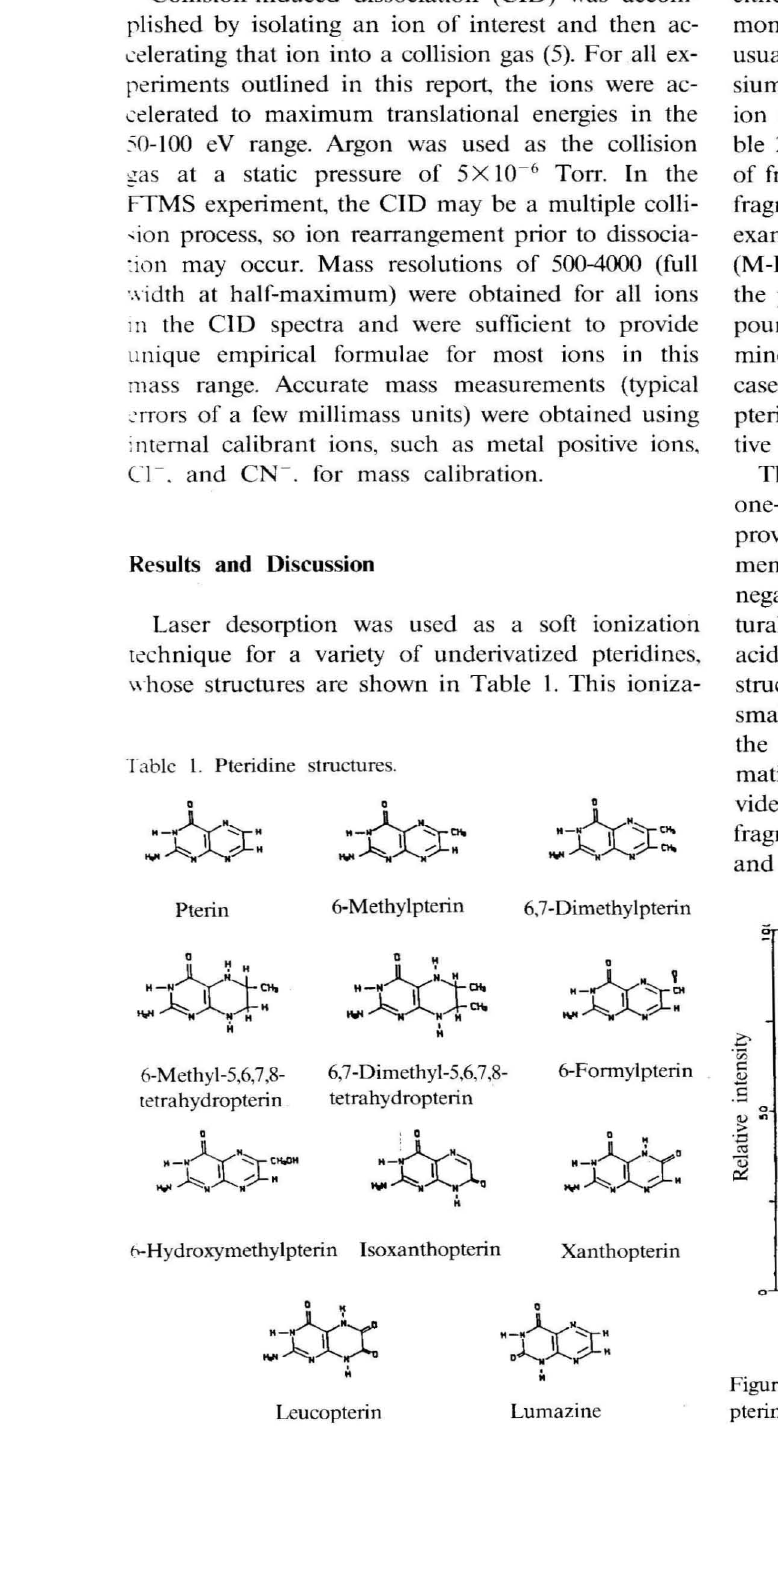
Figure 1. Negative ion laser desorption FfMS spectrum of